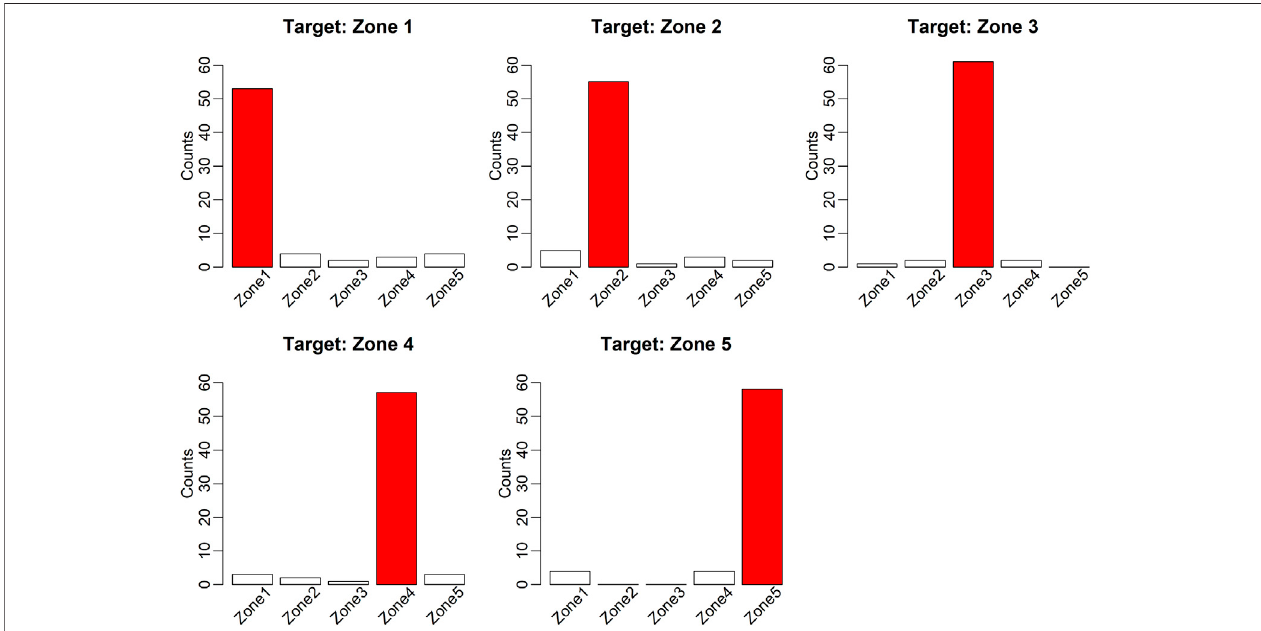
FIGURE 6 | Zonal CNN model prediction for each zone using time-domain – stacked encoding approach.